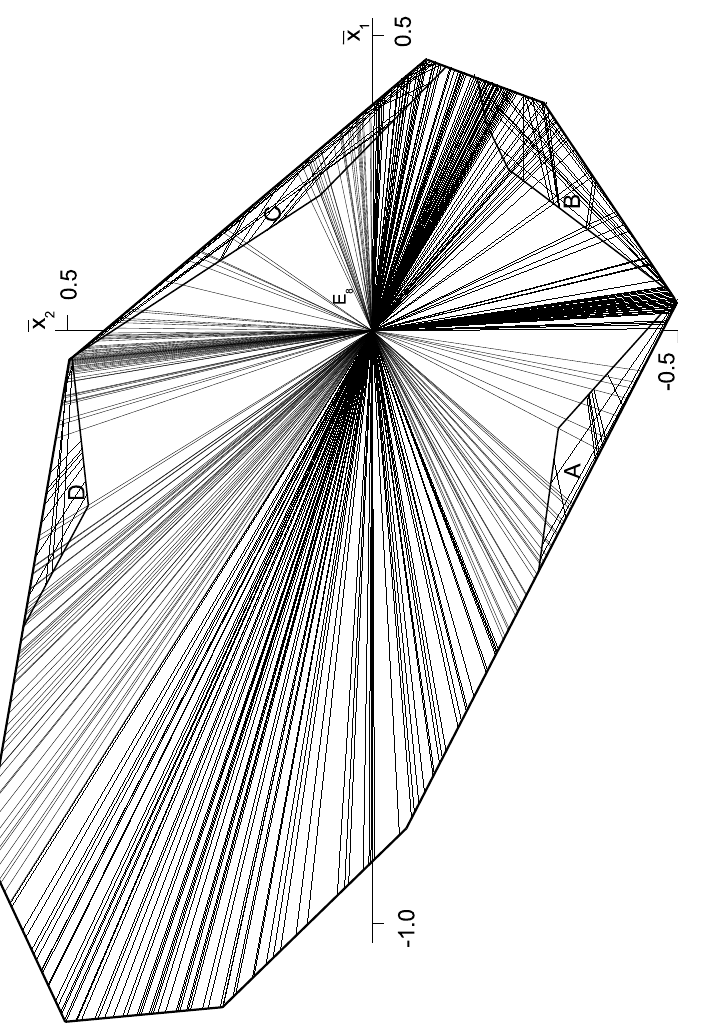
Figure 1. Existencechart through the C E